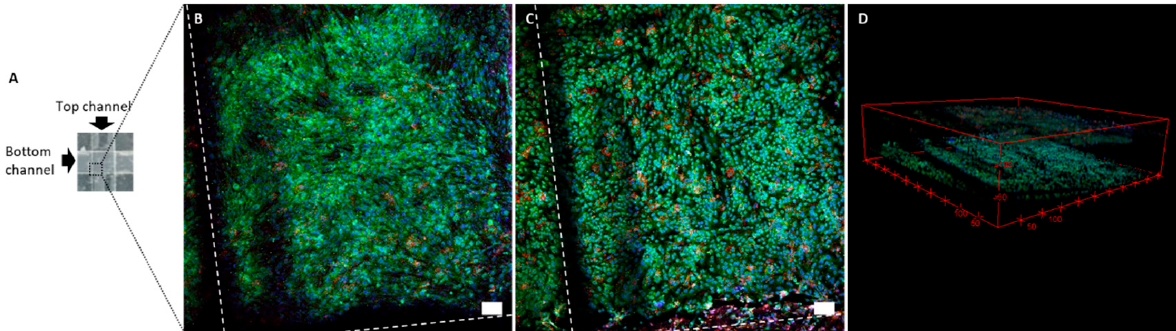
8 of 13 Figure 3. Organ-on-a-Chip (OoC) device assembly. ( A ) OoC in the alignment block during the